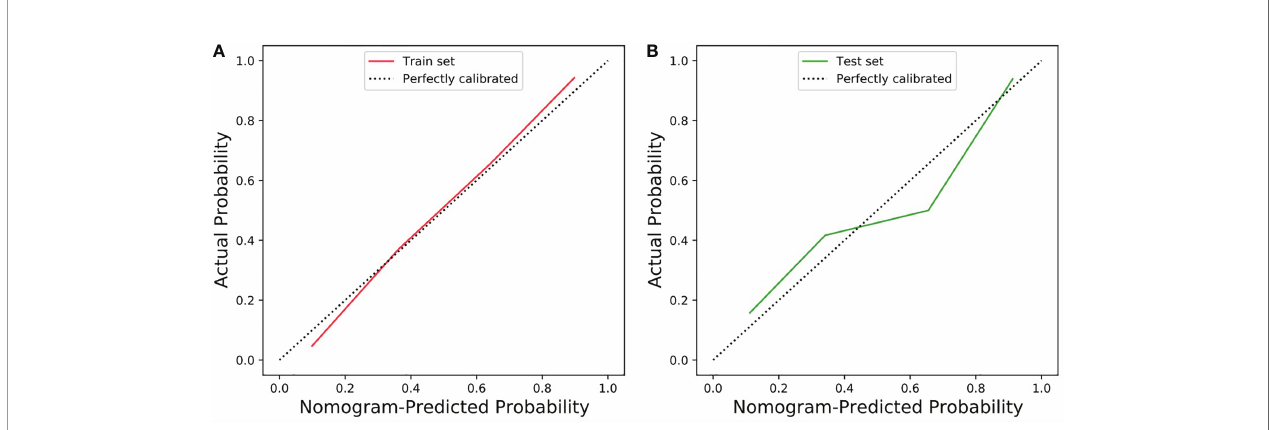
FIGURE 5 | Calibration curve of the radiomic-clinical nomogram in the training and test sets. (A) Calibration curve of the radiomic-clinical nomogram in the training set. (B) Calibration curve of the radiomic-clinical nomogram in the test set. The calibration curve showed the calibration of the models in terms of the consistency between the predictive performance of CS-PAs and the actual results observed for calibration. The Y-axis represents the actual performance, and the X-axis represents the performance predicted by the nomogram. The oblique dashed line represents the perfect prediction by an ideal model. The red and green solid lines represent the performance of the nomogram in the training set and the test set, respectively. In addition, a fi t closer to the diagonal dashed line indicates a better prediction. (The Hosmer – Lemeshow test showed p =0.367 and p =0.113 in the training and test set,